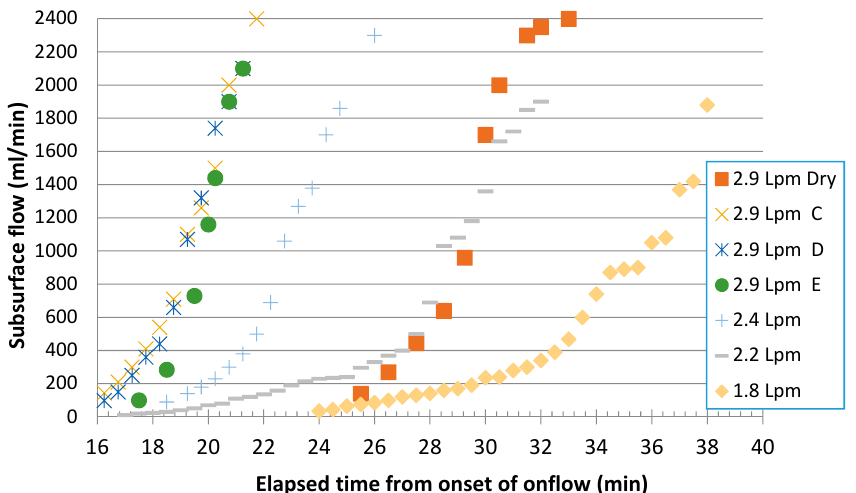
Figure 6. Sandbox subsurface outflow rate at 2 m downslope as it depends on elapsed time after onset of onflow at rates listed for 20.6% bed slope and 143 mm depth sand. All tests under conditions of previous ‘natural drainage’ except as indicated for the ‘dry’ sand case at 2.9 Lpm.